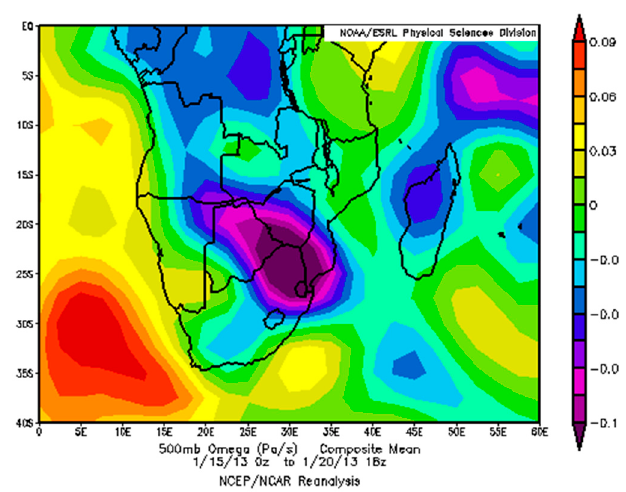
Figure 6. National Center for Environmental Prediction / National Center for Atmospheric Research Figure 6 . National Center for Environmental Prediction/National Center for Atmospheric Research (NCEP / NCAR) re-analysis Omega at 500 mb (https: // www.esrl.noaa.gov / psd / data / composites / hour / ). (NCEP/NCAR) re-analysis Omega at 500 mb Omega composites between 15 and 20 January 2013. Strongest negative anomalies can increase vertical (https://www.esrl.noaa.gov/psd/data/composites/hour/). Omega composites between 15 and 20 shear favorable for formation of convection over land. January 2013. Strongest negative anomalies can increase vertical shear favorable for formation of convection over land.